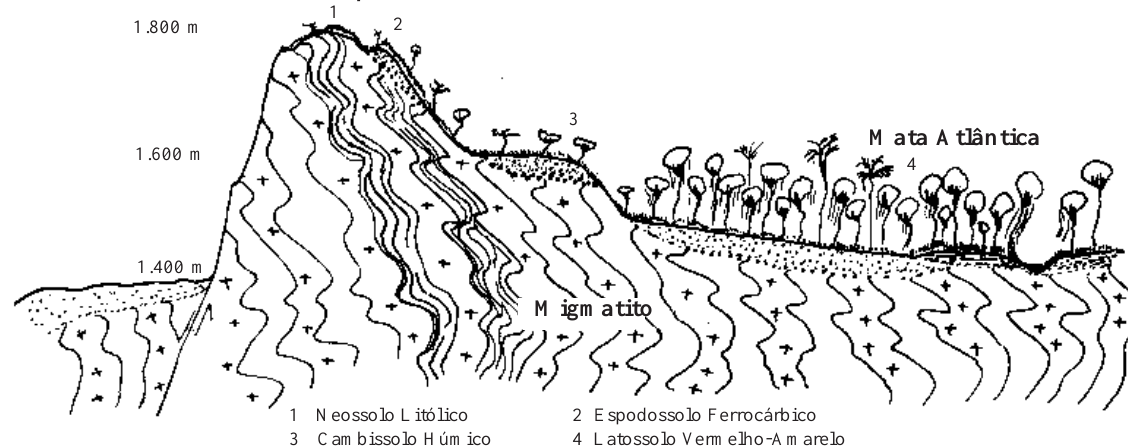
Figura 1. Transecto do pico do Boné até o leito do córrego do Boné, esquematizando os diferentes estratos e os solos